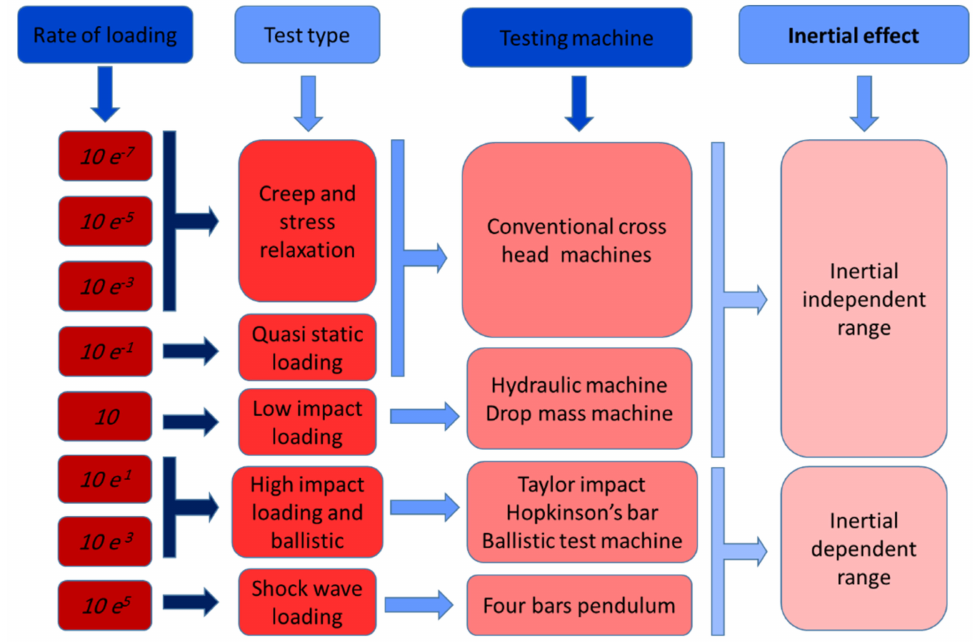
Figure 2. Experimental tests for composite material characterization and variation of loading